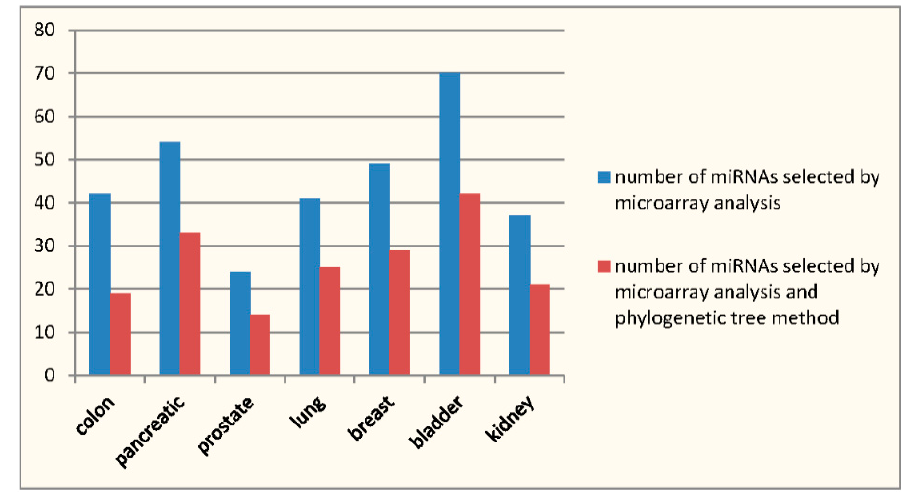
Figure 1. The numbers of miRNA selected by the proposed method or the microarray analysis.